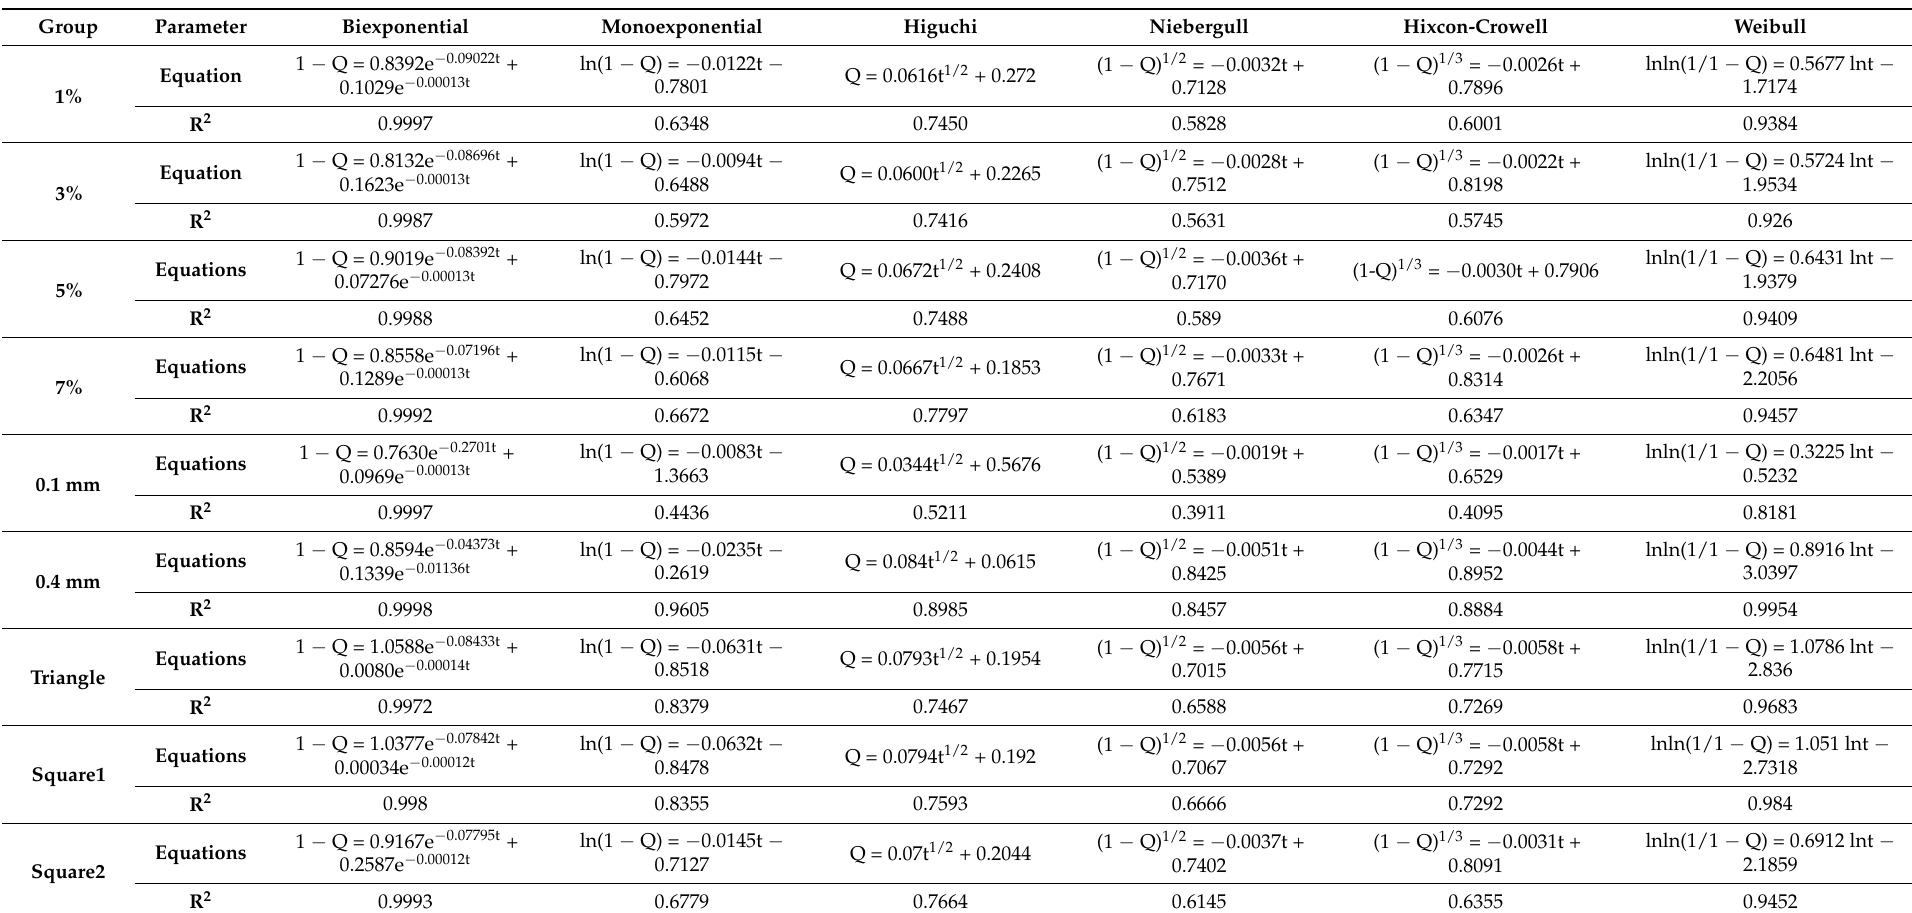
Table 6. Equation and correlation coefficient (R 2 ) of scaffolds with different curcumin loadings (1%, 3%, 5%, 7%, w / w , honeycomb), 7% ( w / w ) scaffolds with different thickness (0.1, 0.2, 0.4 mm, honeycomb), and 7% ( w / w ) scaffolds with different pore shapes (honeycomb, triangle, square 1, square 2, thickness = 0.2 mm) of curcumin release profile in release kinetic